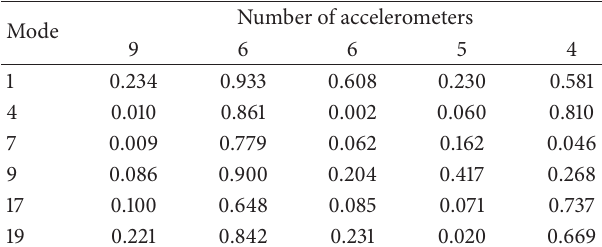
Table 8: The MAC values of acceleration damage parameter in Y transitional direction.